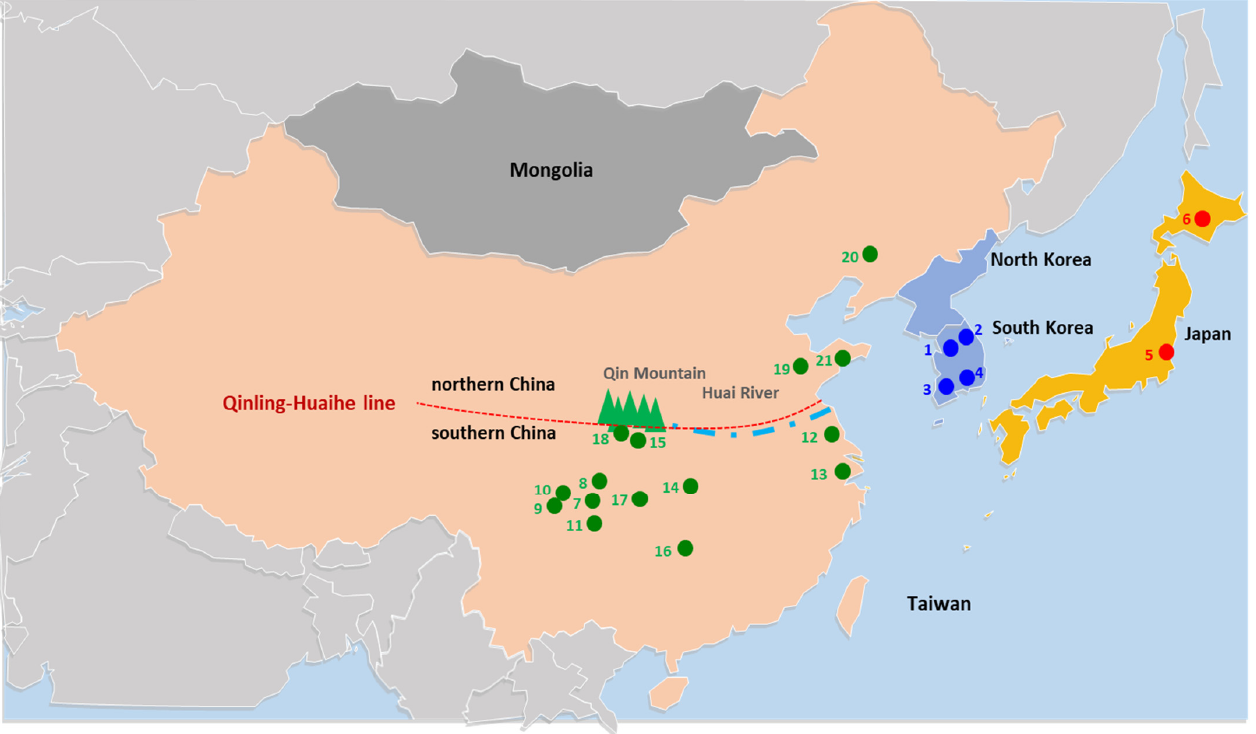
Figure 1. Sampling locations of Bombyx mandarina sequenced in this study and obtained from public data. General locality names are as follows: 1, Gapyeong; 2, Inje; 3, Gwangju; and 4, Sacheon (from South Korea); 5, Tsukuba and 6, Hokkaido (from Japan); 7, Ziyang; 8, Nanchong; 9, Hongya; 10, Pengshan; 11, Luzhou; 12, Yancheng; 13, Suzhou; 14, Yichang; 15, Ankang; 16, Hunan; 17, Chongqing; 18, Shiquan (from southern China); and 19, Qingzhou, Shandong; 20, Shenyang, Liaoning; and 21, Haiyang (from northern China). Coordinates of the sampling sites for South Korean individuals are as follows: 1, Gapyeong, 37°57 ′ 54.5 ″ N, 127°26 ′ 35.7 ″ E; 2, Inje, 37°55 ′ 46.1 ″ N, 128°23 ′ 15.9 ″ E; 3, Gwangju, 35°10 ′ 47.4 ″ N, 126°56 ′ 27.6 ″ E; and 4, Sacheon, 35°04 ′ 22.6 ″ N, 128°00 ′ 37.9 ″ E.